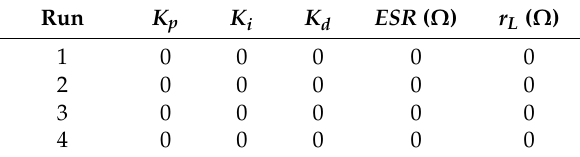
Table 3. Central point data collected from the cloud data